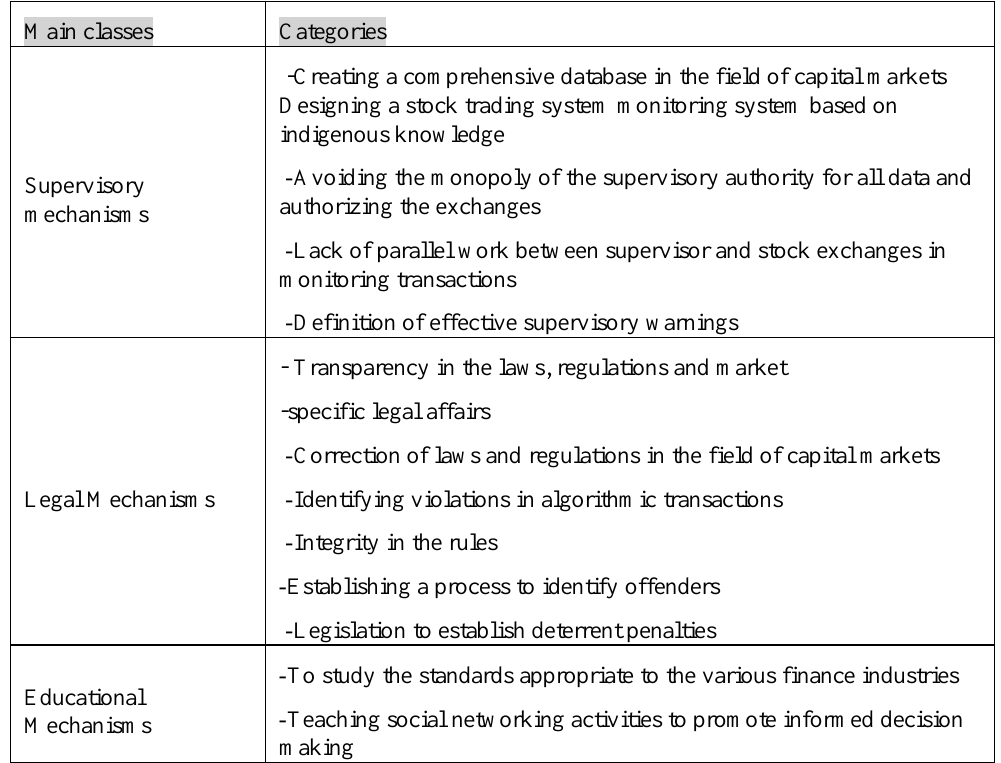
Categories Main